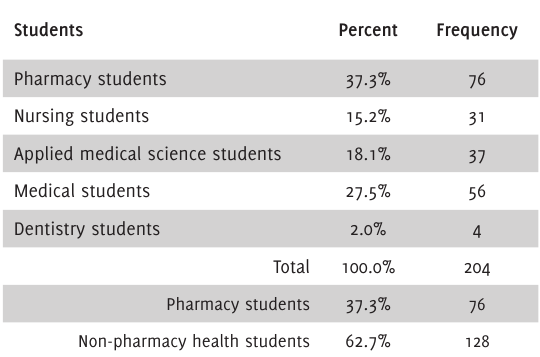
Table 1. Distribution of pharmacy, nursing, applied medical science, medical, and dentistry students in self-administered questionnaire by percent and